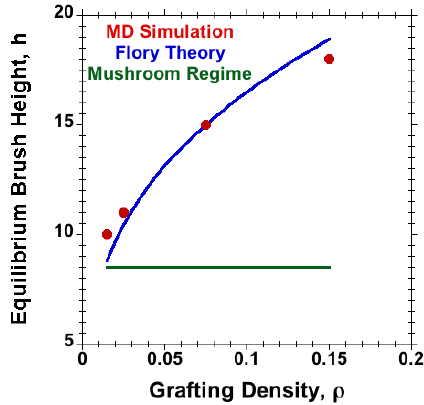
Figure 2. Equilibrium-brush height ( h ) versus grafting density ( ρ ) for M = 20 flexible chains with N = 30 under good-solvent conditions. The ρ -independent reference result for the mushroom regime is marked by the horizontal line. Flory results according to Section